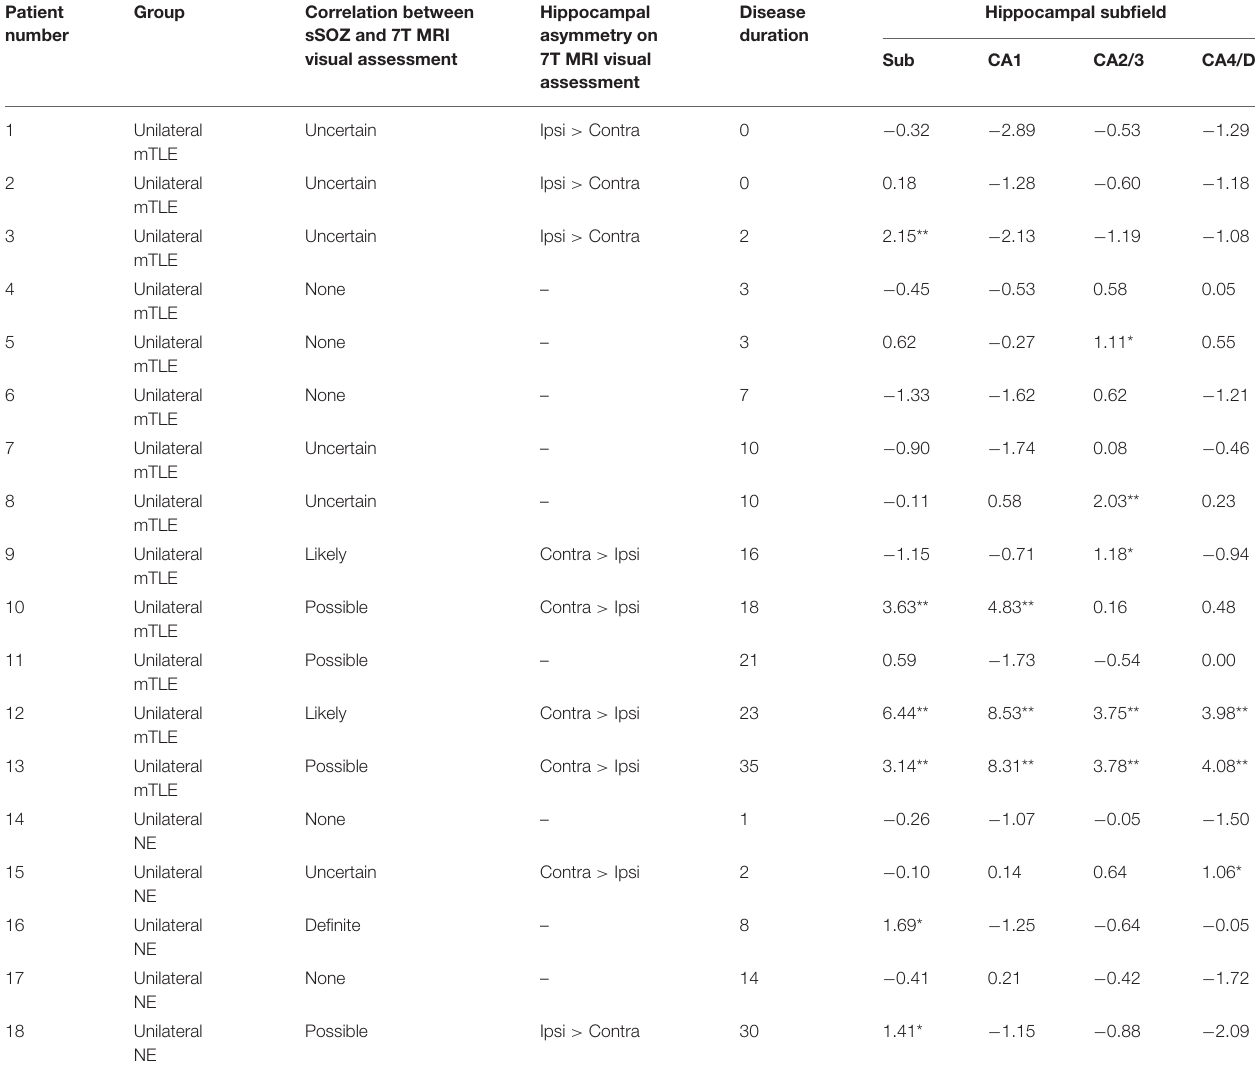
TABLE 3 | Normalized asymmetry index